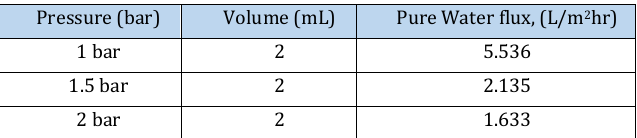
decrease of hydrophilicity 3.4 Membrane Rejection Analysis of Glucose and Chemical Oxygen Demand by PVDF/e-TiO2 Membrane As it can be seen in the Figure 4, PVDF/e-TiO2-2 bar membrane has lower value of glucose rejection. As the hot-pressing pressure increase, the glucose rejection (%) was slightly decreases. However, as the pressure increases the chemical oxygen demand(COD) increases because dissolved oxygen is used by the microorganism in the surrounding and the organic content removed in retentate side together with glucose.